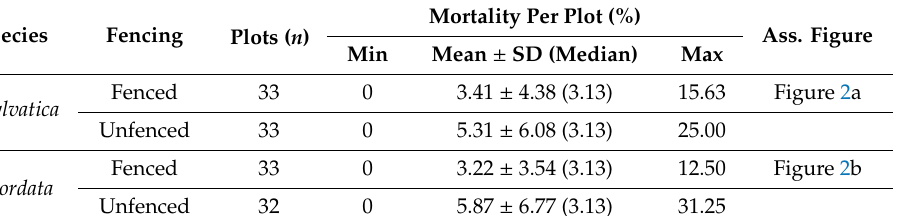
Table 1. Mortality per plot for F. sylvatica and T. cordata seedlings after the first growing season. Shown are detected minimum (Min), mean ± standard deviation (SD), median, and maximum (Max) mortality of dead seedlings on fenced and unfenced plots after the growing season 2017 and associated figures (Ass. figure).